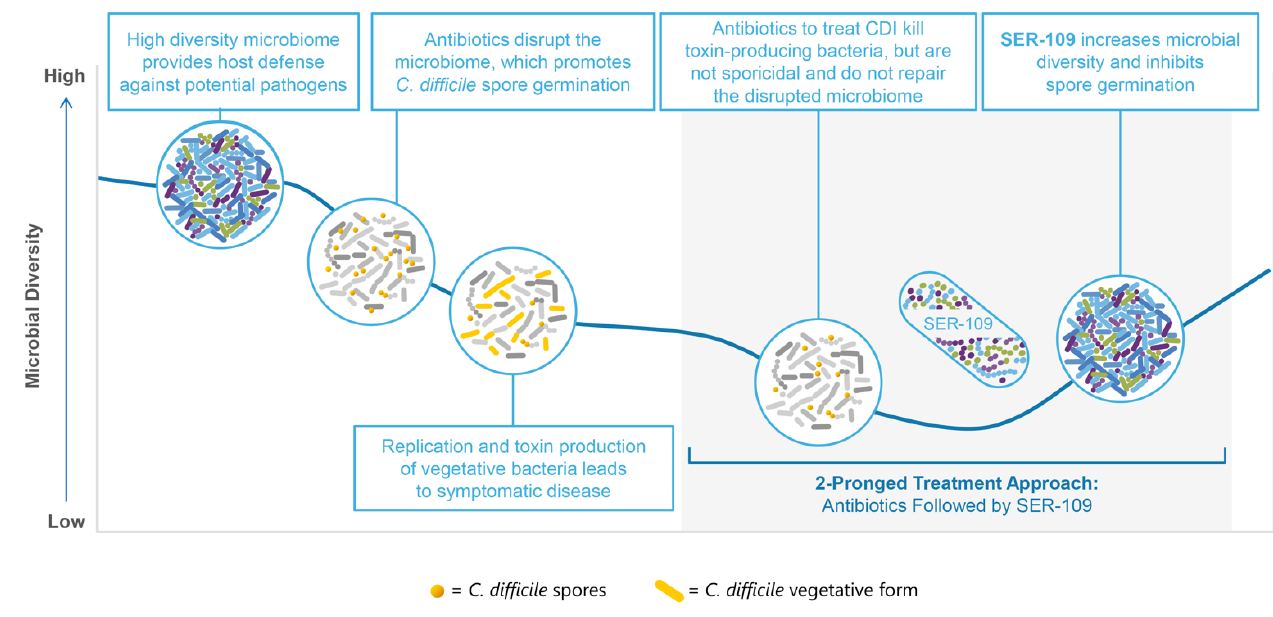
Figure 1. C. difficile infection (CDI) is a two-hit process requiring a 2-pronged treatment